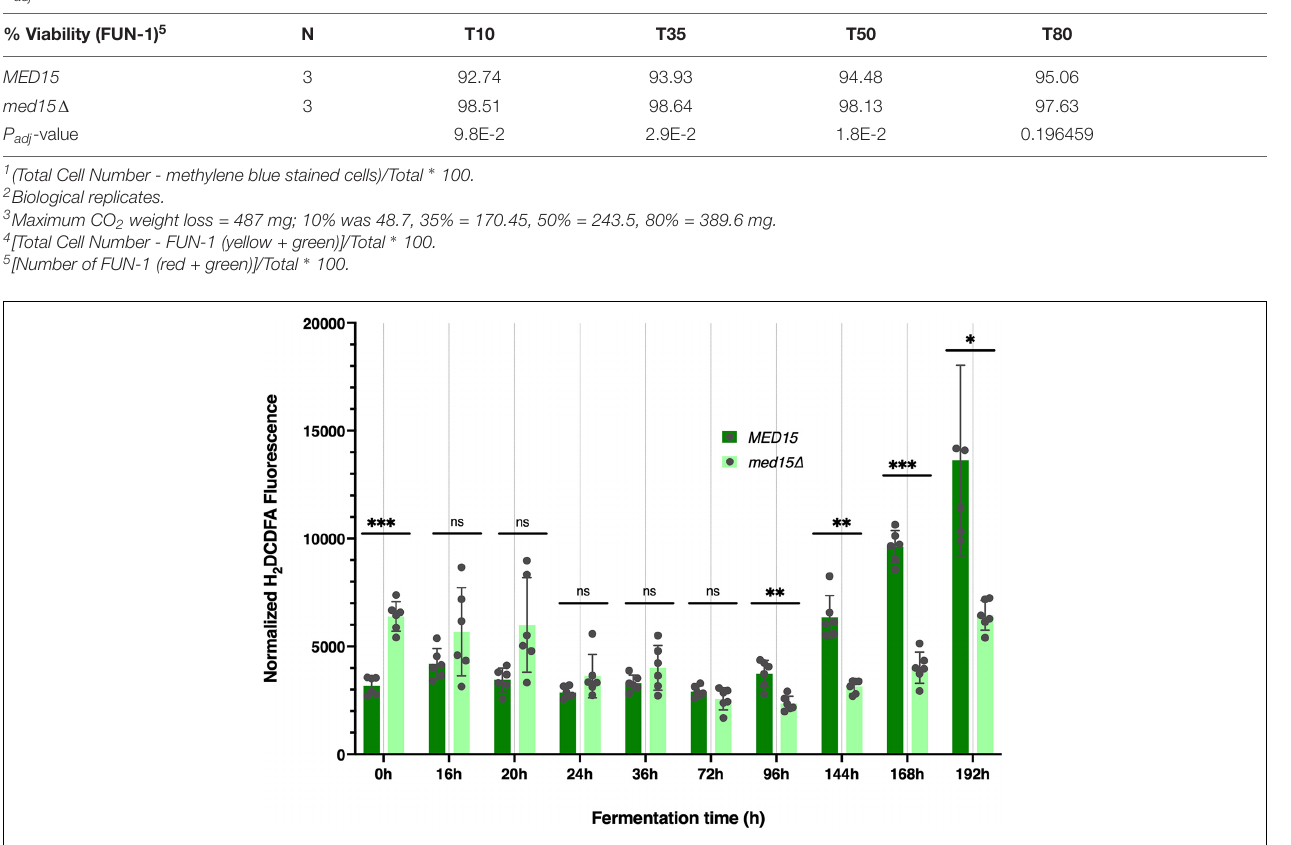
FIGURE 3 | Reactive oxygen species are elevated at late times in fermentation specifically in the wild type strain. Reactive oxygen was measured at each time point in the fermentation time course and is shown as total arbitrary fluorescence units in H 2 DCDFA stained cells minus the fluorescence in unstained cells normalized to cell density. 3 biological replicates (transformants) and two technical replicates are shown; error bars are the standard deviation of the mean. Adjusted P values were determined with multiple two-tailed t -test and indicated as *, p ≤ 0.05; **, p ≤ 0.01; ***, p ≤